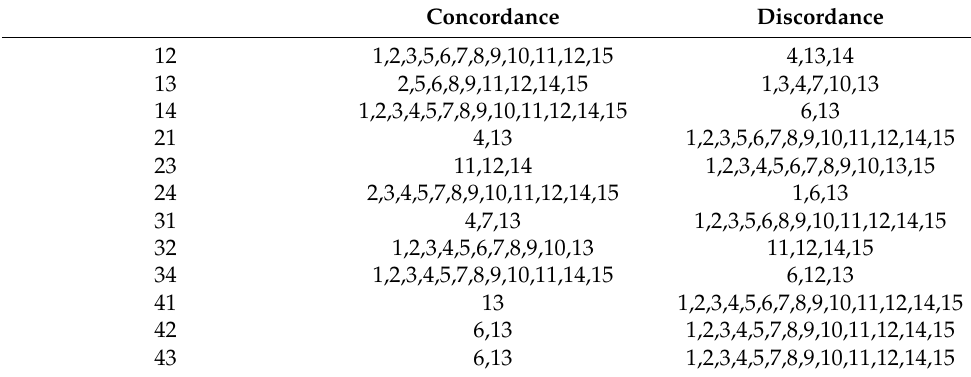
Table 18. Concordance and discordance sets.